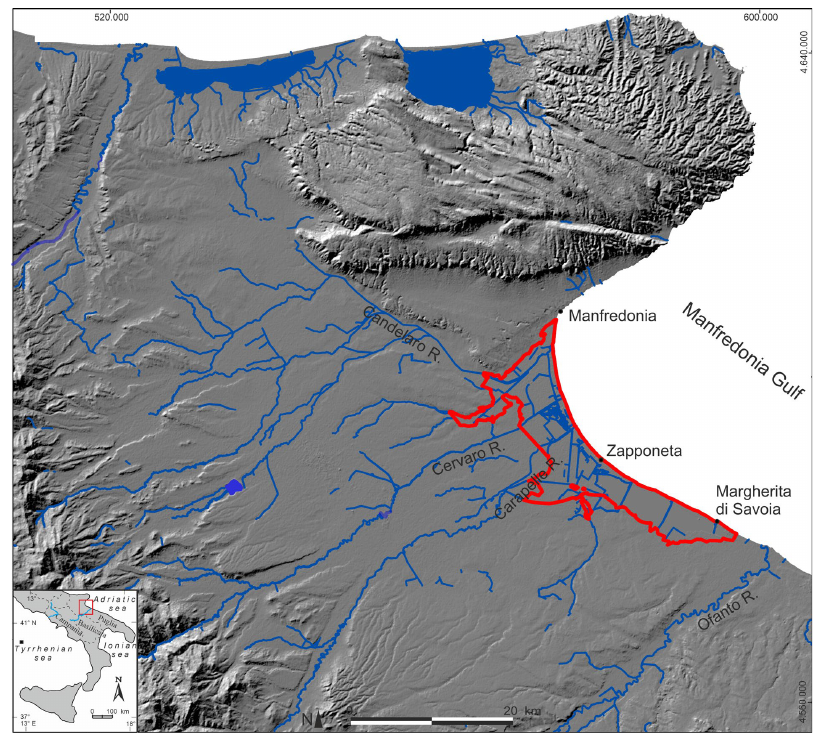
Figure 1. Study area location. The red line identifies the boundary of the investigated area, corresponding to the area strongly affected by land reclamation and drainage activities since the beginning of the XIX century (Digital Elevation Model from TINITALY [50]).